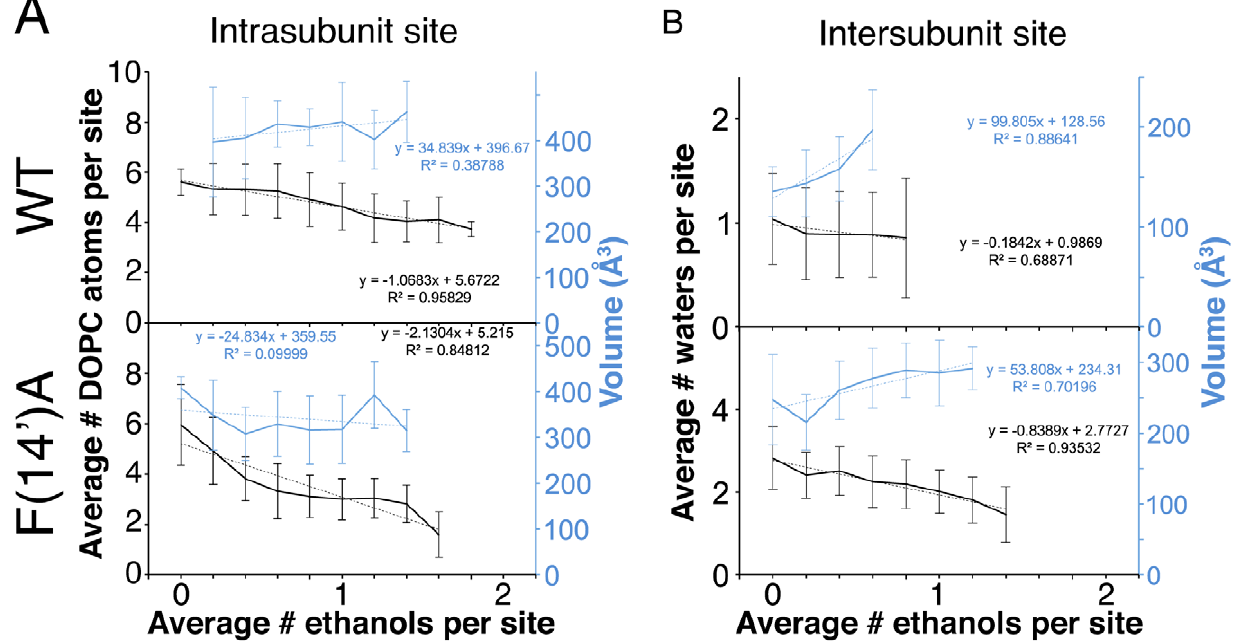
Figure 5. Cavity occupancy correlations. ( A ) Average number of DOPC lipid atoms (black, left axis) and average cavity volume (blue, right axis) for each intra-subunit cavity as a function of the average number of ethanol molecules in the same site, with standard errors. ( B ) Average number of water molecules (black, left axis) and average cavity volume (blue, right axis) for each inter-subunit cavity as functions of the average number of ethanol molecules in the same site, with standard errors. In ( A ) and ( B ), linear fits (dotted lines) are also shown, with the corresponding equations and correlation values (R 2 ). doi:10.1371/journal.pcbi.1002710.g005 PLOS Computational Biology |